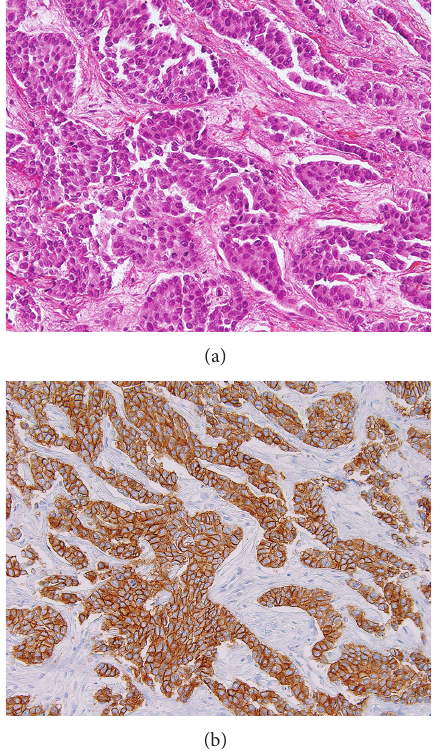
Figure 2: Breast tumor. (a) Biopsy specimen (staining with H&E, original magnification x200). (b) HER2 overexpression (3+) of tumor cells detected by immunohistochemistry (immunoperox- idase staining, primary monoclonal anti-HER2 antibody (clone CB11), original magnification x200).